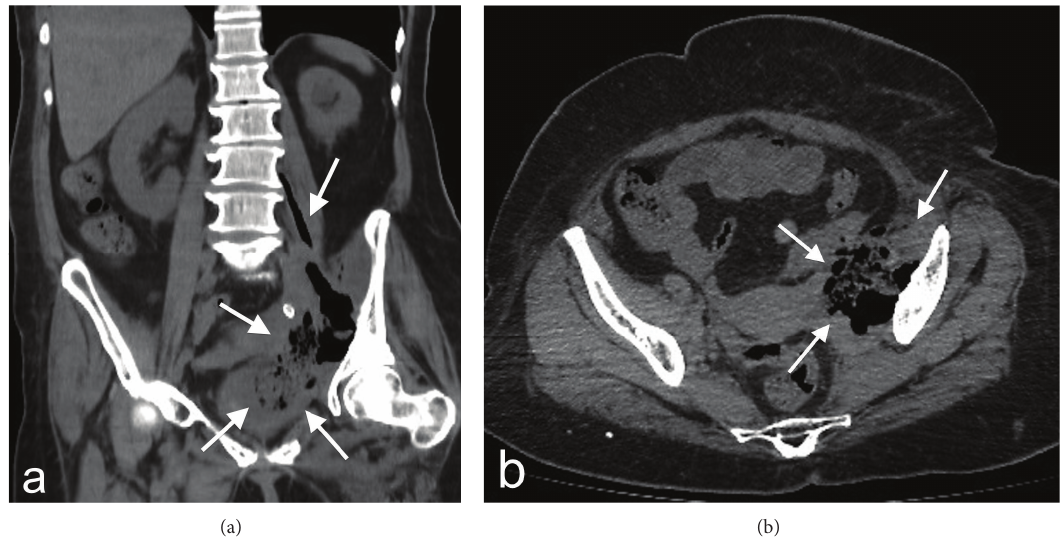
Figure 1: In coronal reformat (a) and axial (b) section computerized tomography examination, appearance is observed in concordance with abscess, extending from left iliopsoas level to inferior pelvic space and containing air and intense fluid densities (white arrows).